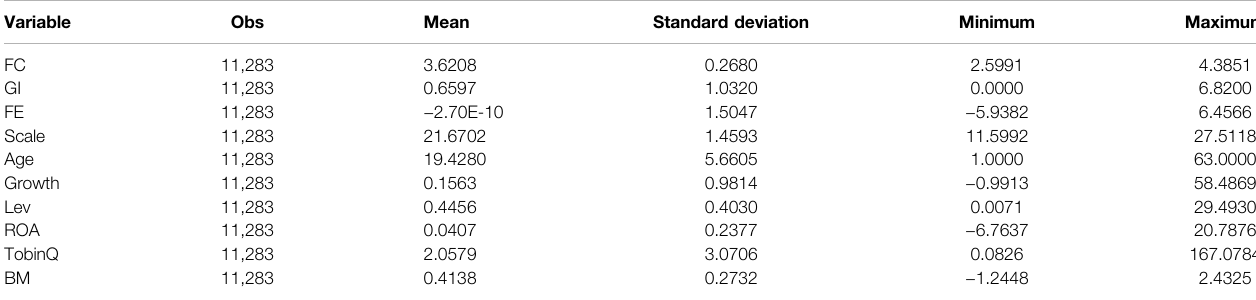
TABLE 4 | Descriptive statistics before winsorization.